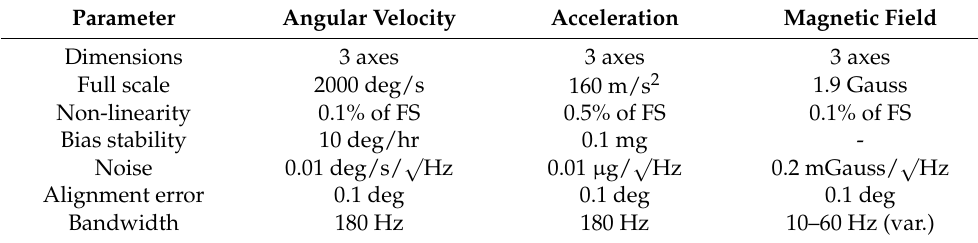
Table 1. Technical properties of the MTw2 Awinda Wireless 3DOF Motion Tracker (www.xsens.com, accessed on 8 April 2020).